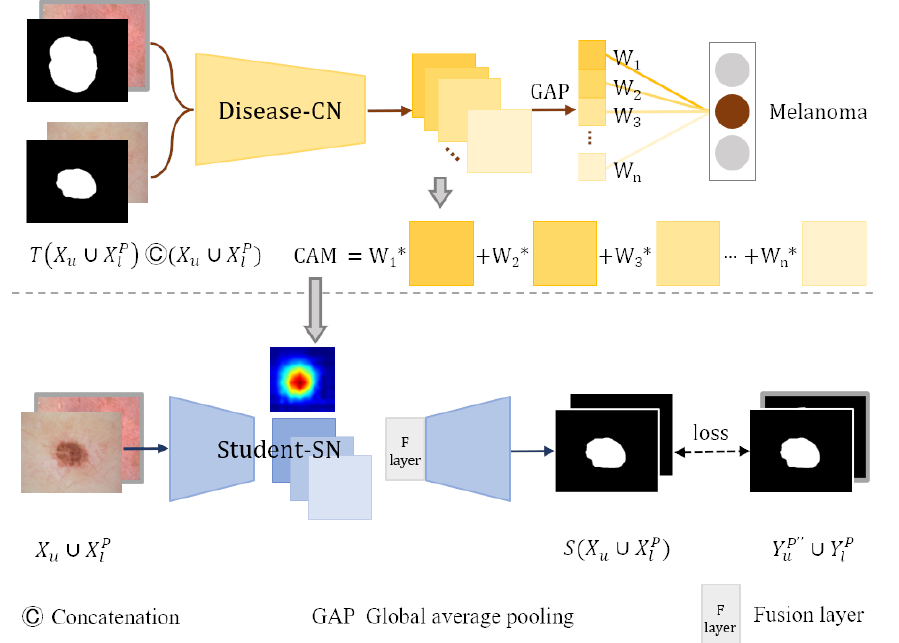
Figure 4. Student-SN learning in weakly labeled